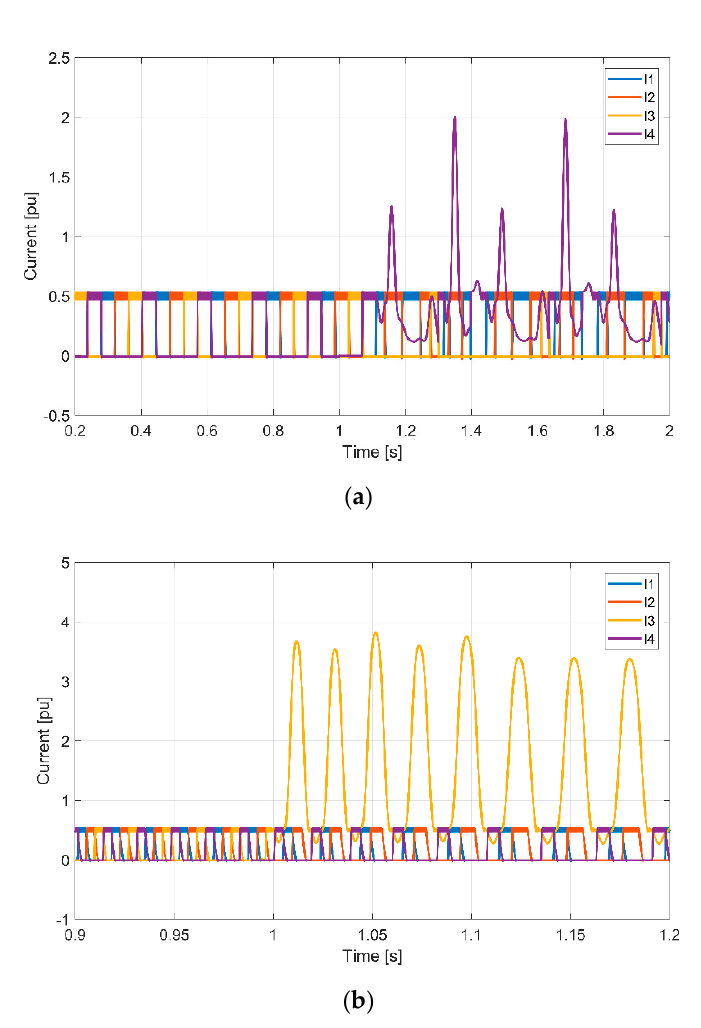
Figure 14. Motor winding currents of the SRM in normal operation and short-circuit failure of power device ( a ) 60 rpm and S 1 D ( b ) 600 rpm and S 1 C (simulation result).